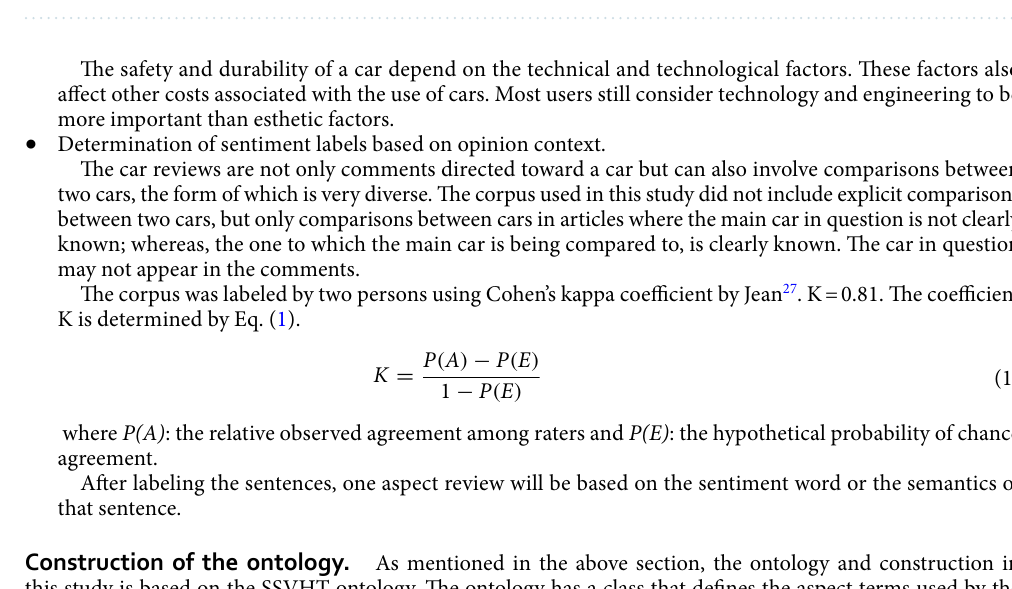
Figure 1. Semantic and sentimental ontology model of car